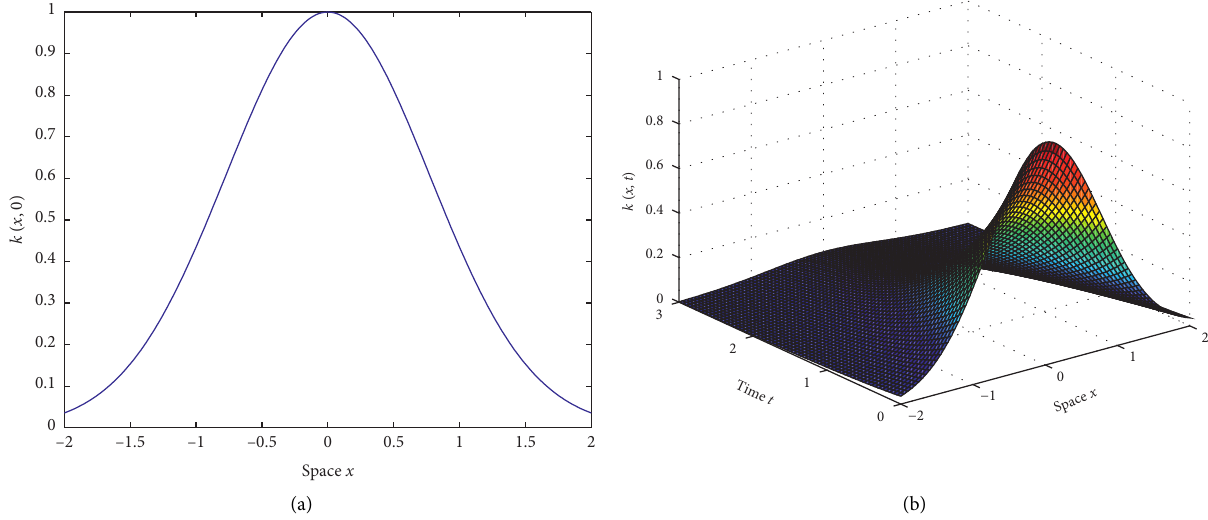
Figure 1: Evolution of the spatial capital distribution corresponding to A � 0 . 1 , n � 0 . 03 , ρ � 0 . 05 , σ � 3, and r